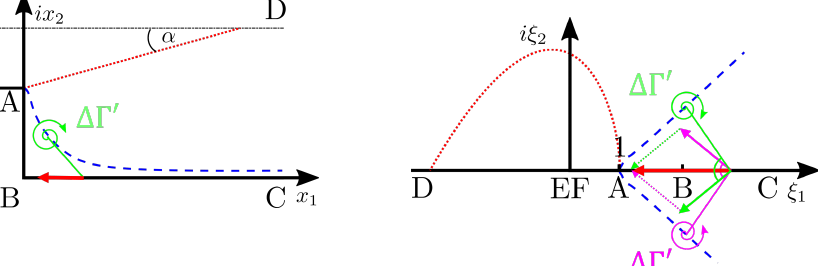
Figure 3. Illustration of how impermeability boundary conditions are met by use of a mirror vortex (not to scale): the wall normal velocity component of the original vortex of strength ∆Γ (cid:48) (green) is canceled by its mirror counterpart (pink) such that the resulting velocity (red) is parallel to the walls in the physical ( left ) as well as in the image domain ( right ). The shear layer and the flame front are shown as blue dashed and red dotted lines,